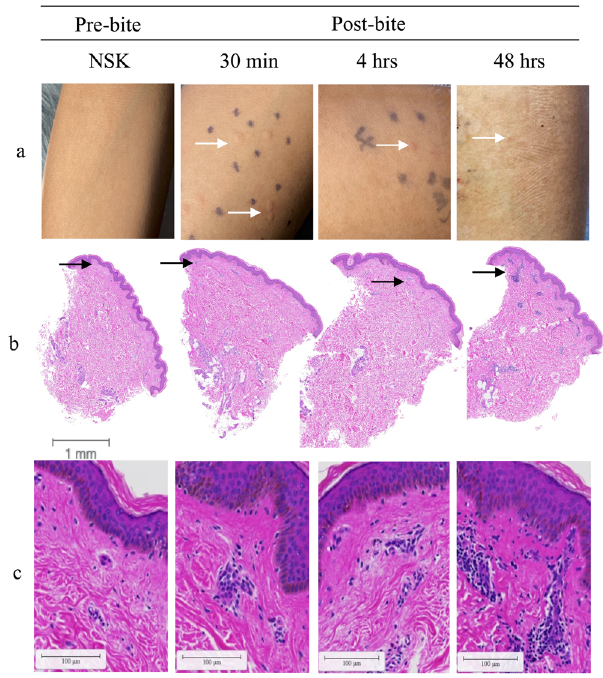
Fig. 2 | Clinical observations of skin reaction pre- and post-bite on gross examination and H&E staining. a Skin immune responses to mosquito bites (left to right) normal skin (NSK), 30min, 4h, and 48h after exposure to fi ve Ae. aegypti mosquitos. b Representative cross-sectional of 3-mm punch biopsies H&E stained at(lefttoright)0h,30min,4h,and48hafterexposureto Ae.aegypti bites.Distinct bite sites were biopsied at different time points. Scale bar is 1mm. Black arrows indicate area ofin fi ltrate. c Magni fi cation ofin fi ltrate indicated by black areas in B, scale bar 100 µ